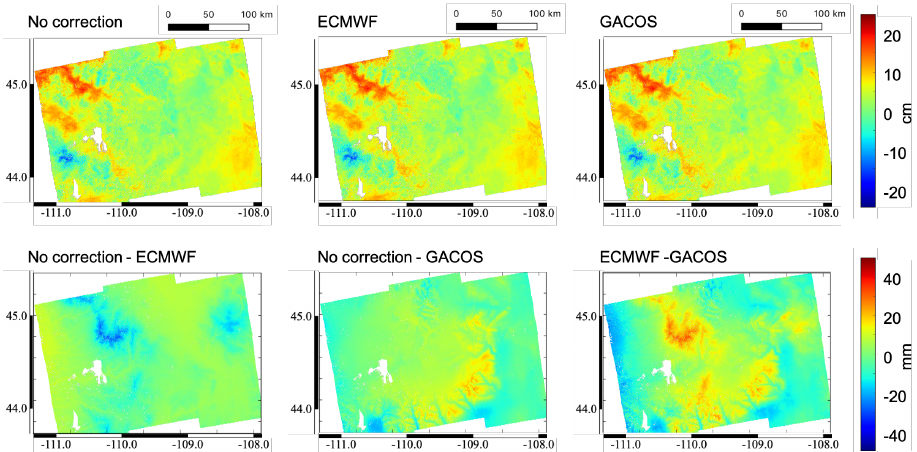
Figure 9. Top row: Cumulative displacement calculated from Frame 49-142 between May 2017 and August 2018 with no atmospheric correction applied ( left ), ECMWF ( middle ) and GACOS ( right ) atmospheric correction applied. In the cumulative displacement plots, high (red) values mark an uplift, while low (blue) values mark subsidence. Bottom row: Differences between each of the cumulative displacement